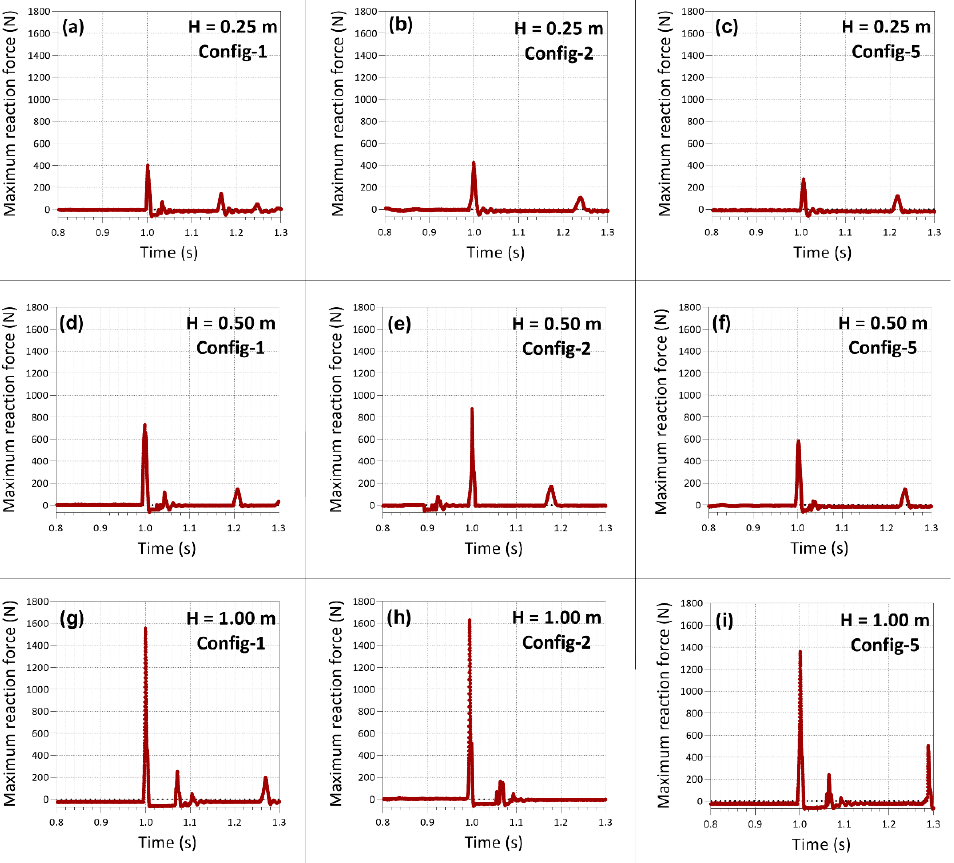
Figure 4. Maximum reaction forces for configurations.